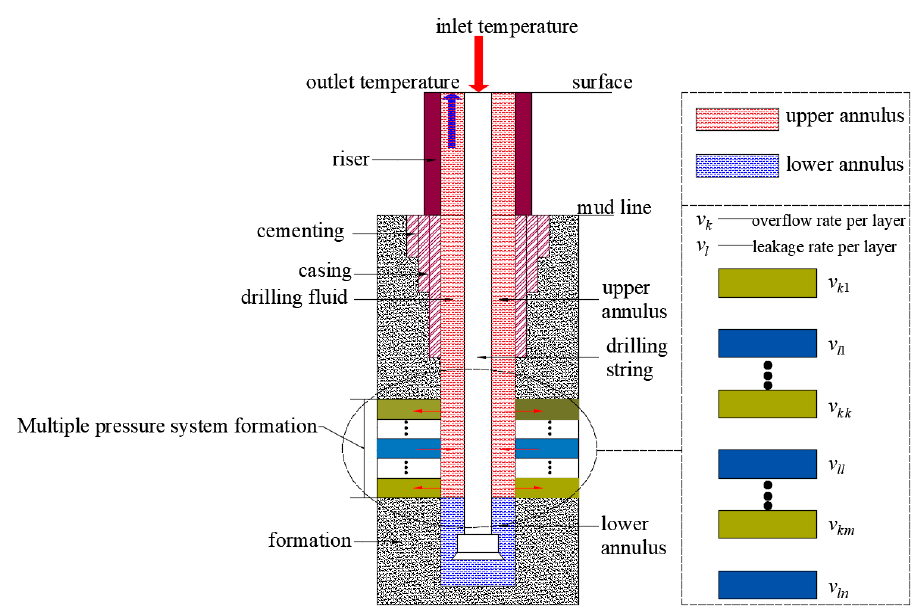
Figure 3. Physical model of multi-pressure system in the middle open hole formation. The thermo-physical parameter of the drilling fluid in the lower annulus, which is located upstream of the multi-pressure system, is not a ff ected by overflow and leakage. The heat transfer in this region is the same as that of the annulus during normal circulation. According to the law of energy conservation, the following Equation (7) can be obtained in the control element: The first item of the equation is the change of internal energy in element during ∆ t time, the second and third items are the convection heat transfer ∆ t , the fourth item is the heat entering the element during ∆ t , and the fifth item is the heat generated by